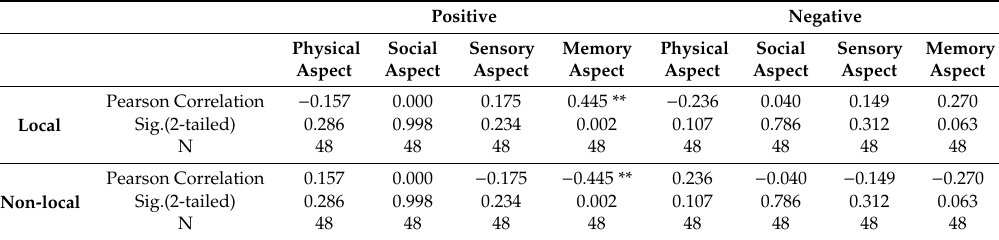
Table 1. Correlation Table.